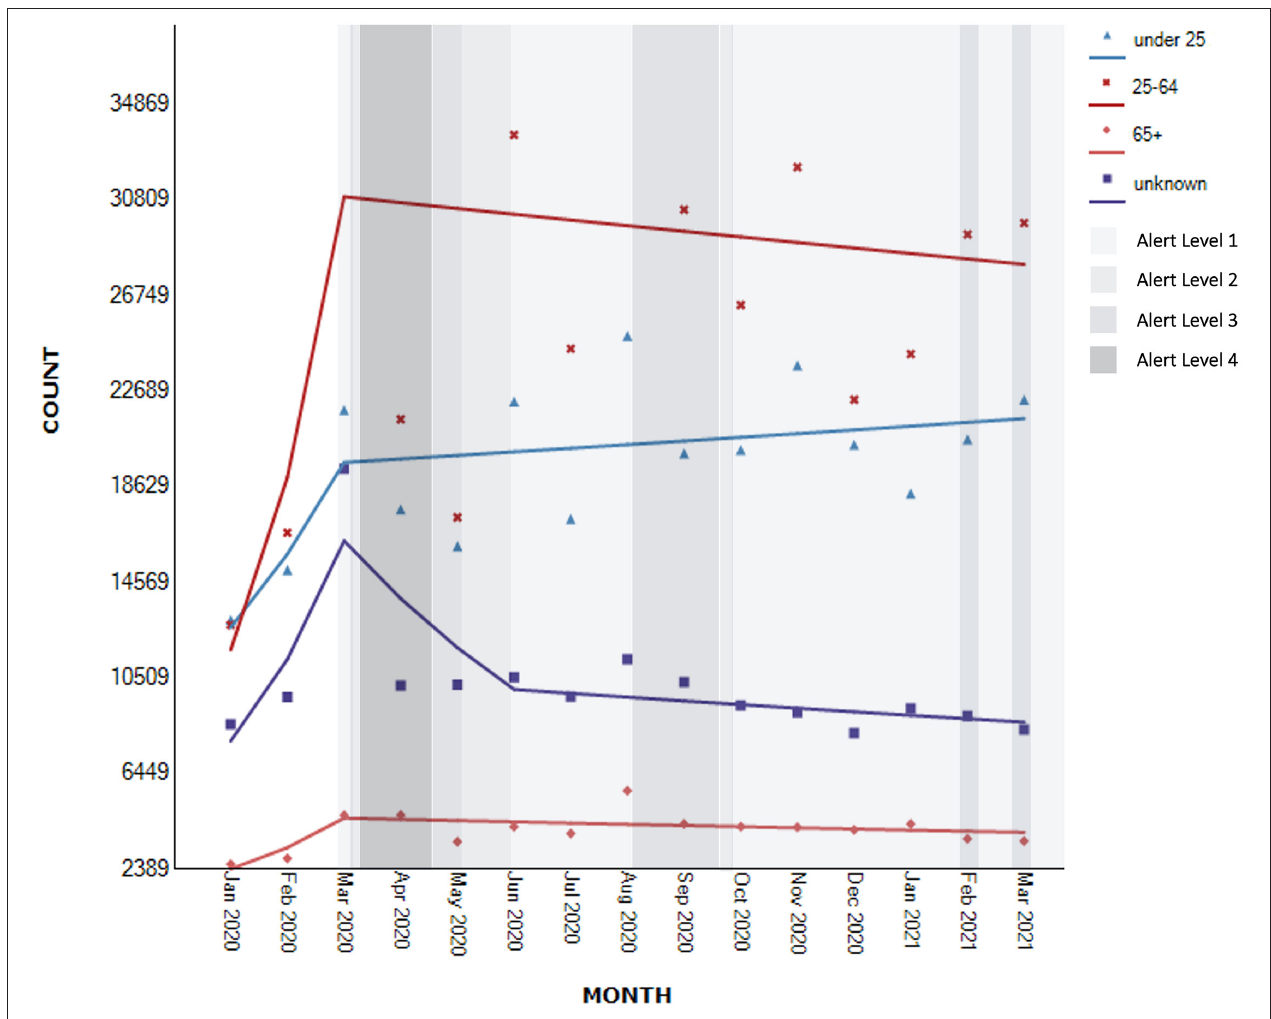
FIGURE 5 | Segmented regression analysis of contacts to national helplines per age group ( N known =